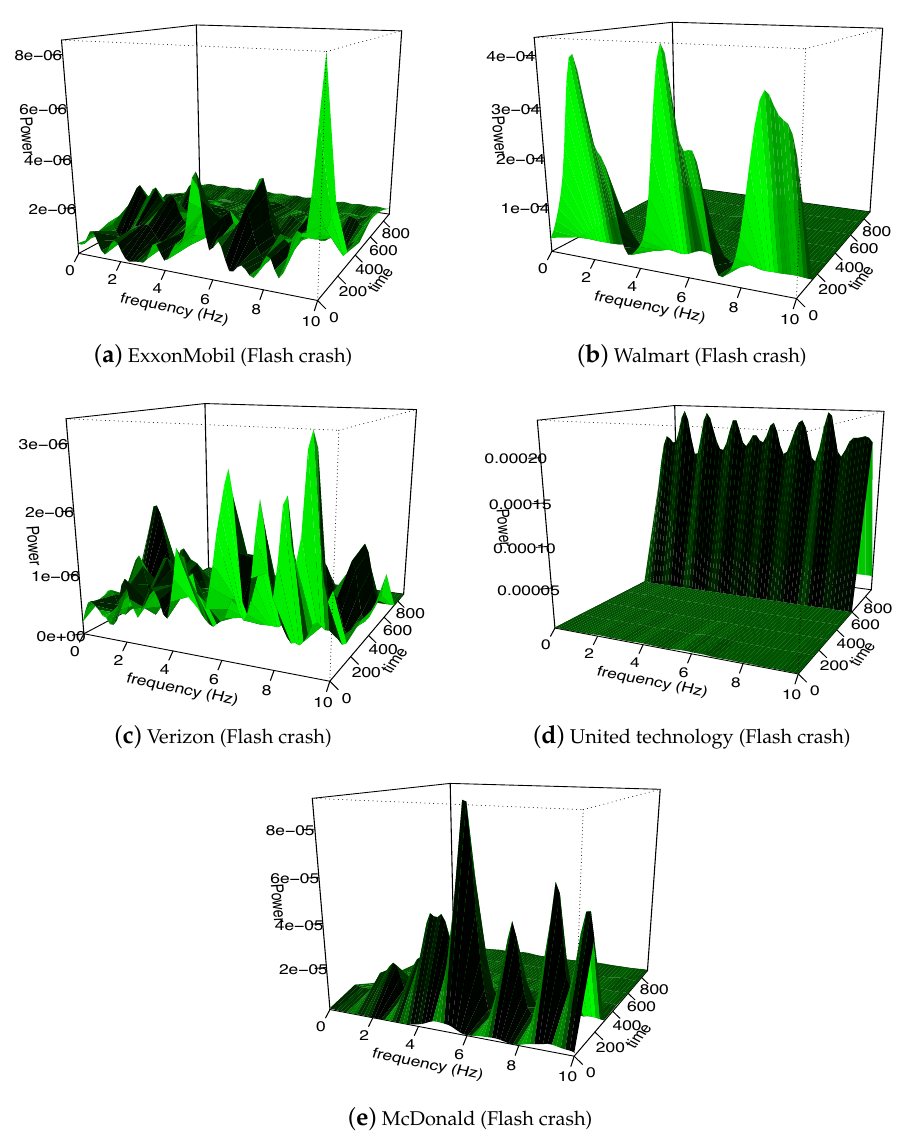
Figure 2. 3D power spectra of the financial data corresponding to the flash crash event.